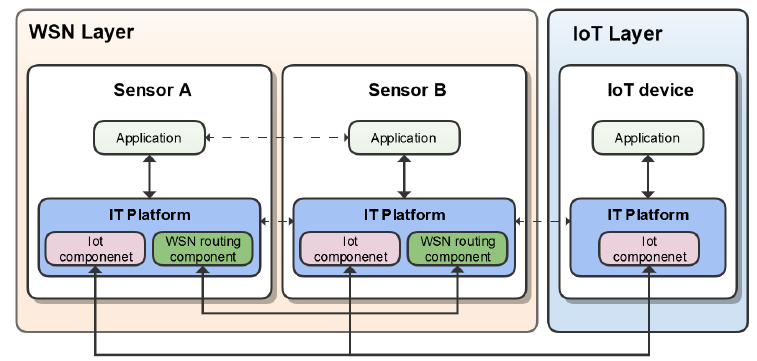
Figure 3. The two layers used by our platform.